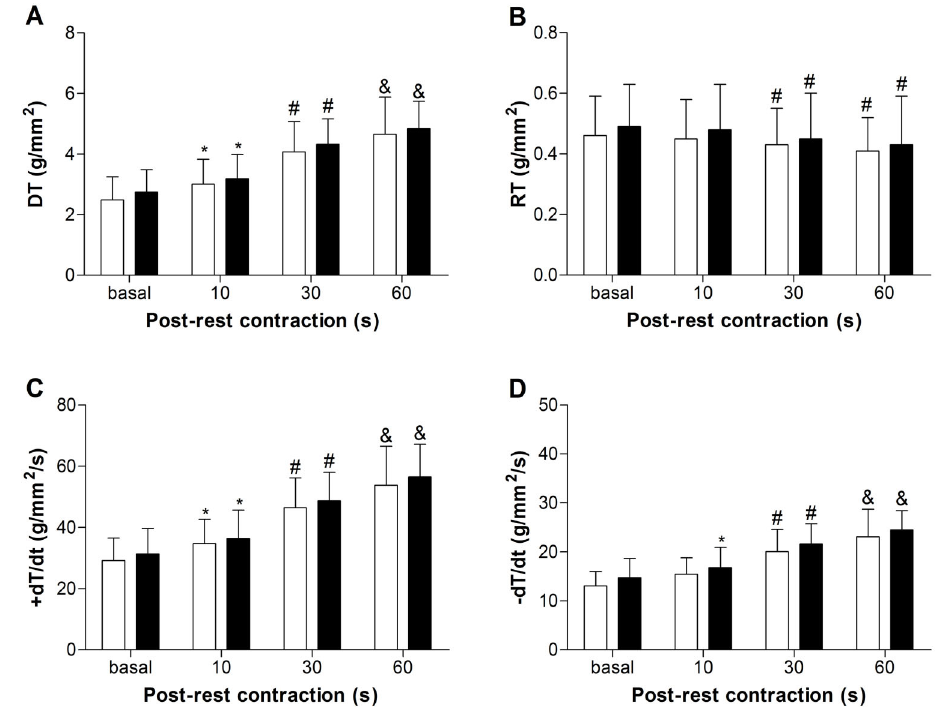
Figure 4. Effects of post-rest contraction on myocardial function in papillary muscles from control (white bars; n=11) and obese (black bars; n=11) rats after 33 weeks. A , DT: maximum developed tension; B , RT: resting tension; C , + dT/dt: peak of positive tension derivatives; D , – dT/dt: peak of negative tension derivatives. Data are reported as means ± SD. *P o 0.05 vs basal; # P o 0.05 vs basal and 10 s; & P o 0.05 vs basal, 10 and 30 s (ANOVA and